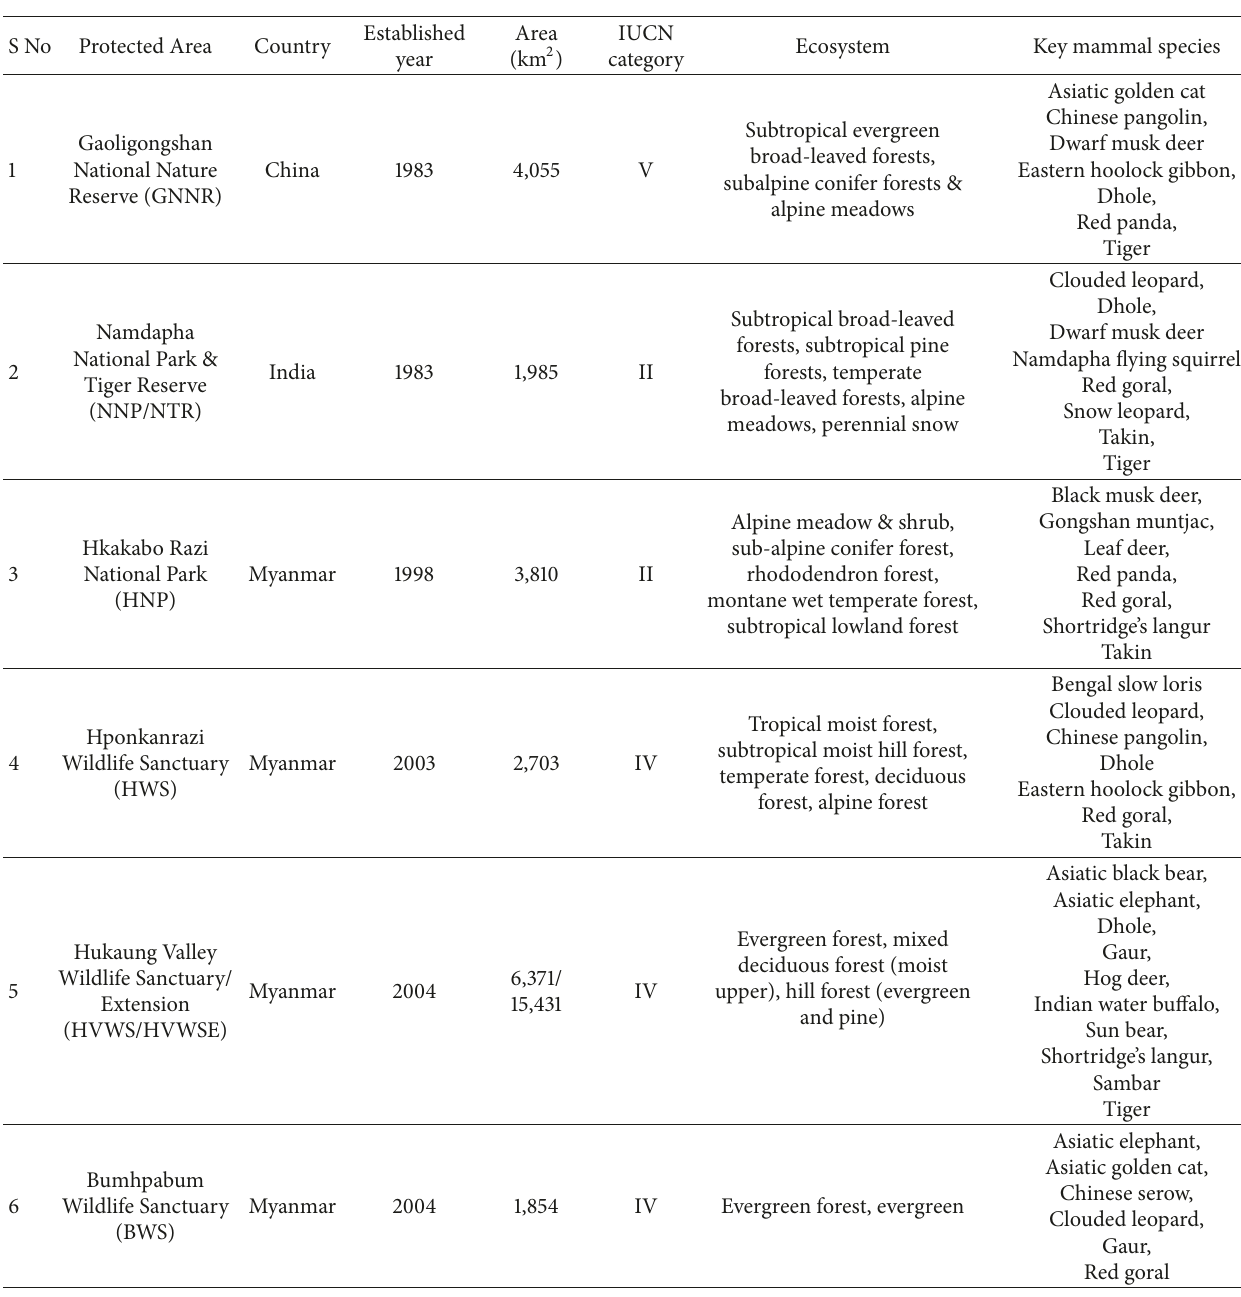
Table 1: Protected areas in the Far-Eastern Himalayan